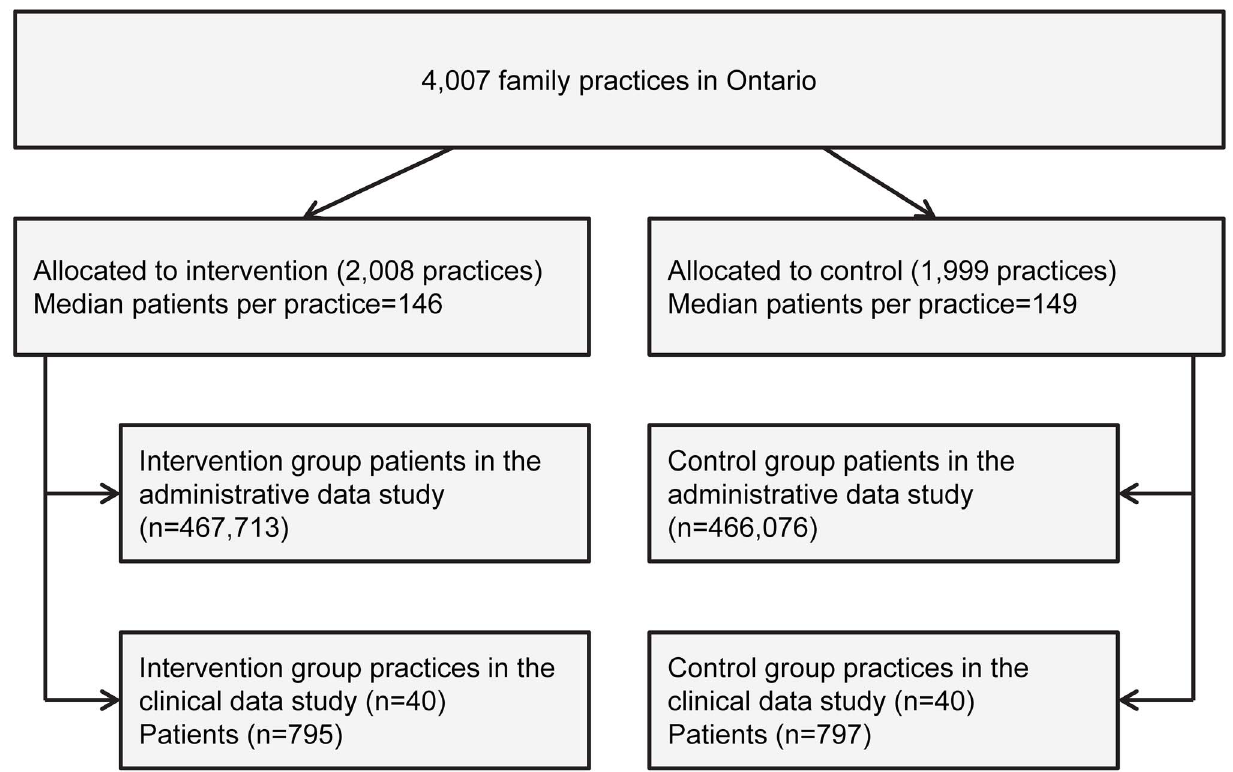
Figure 1. Flow chart of practice and patient randomization in the trial. and 11,536 (2.5%) patients in the control group (odds ratio 1.00, 95% confidence interval 0.96–1.03, p = 0.77). The other clinical event outcomes did not show benefit with the intervention (Table 2). Two of the processes of care secondary outcomes related to coronary artery disease screening were statistically significantly worse in the intervention group: electrocardiograms (38.8% versus 40.2%, odds ratio 0.96, 95% confidence interval 0.93–0.99, p =0.02) and cardiac stress tests or nuclear imaging (7.8% versus 8.1%, odds ratio 0.96, 95% confidence interval 0.93– 1.00, p =0.04). The intervention did not significantly increase